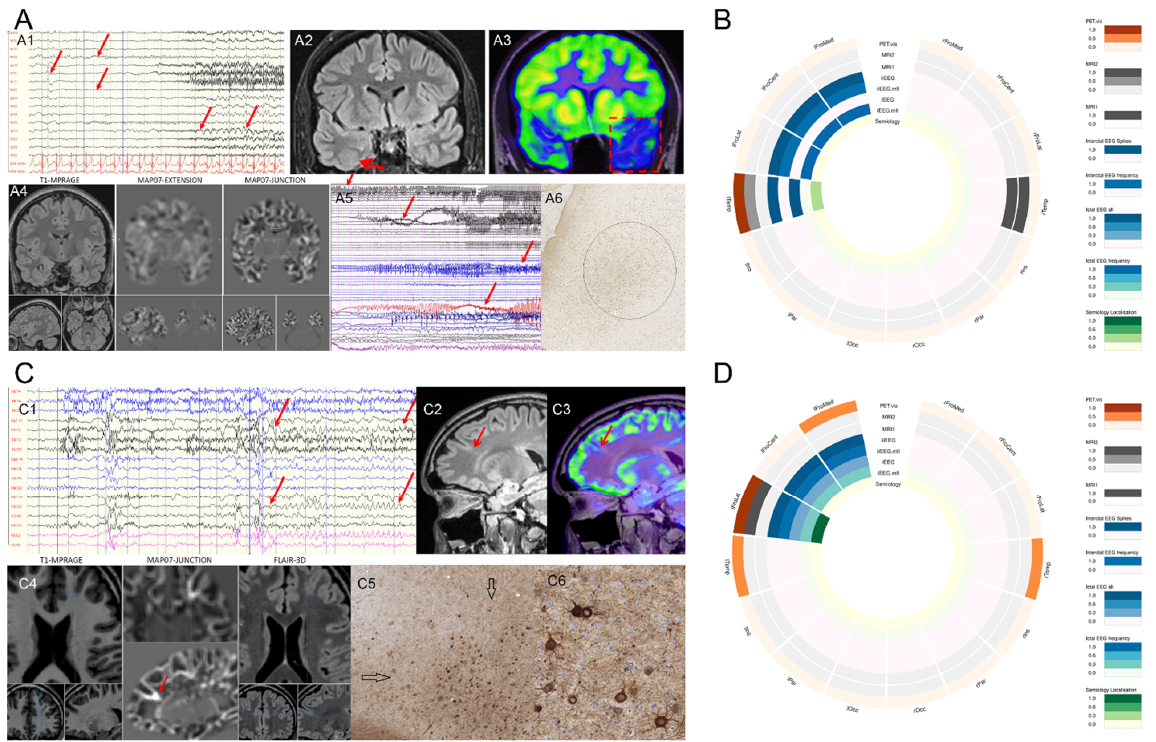
Figure 1. Examples of the results of presurgical evaluation tests proved by pathologic findings. ( A ) A drug-resistant epileptic patient with atypical temporal lobe seizures. ( A1 ) Video-EEG monitoring. During her stereotype seizures, left frontotemporal seizure activity was seen (marked with arrows). ( A2 ) A cranial MRI showed an FCD2 in the right collateral sulcus (arrow), while ( A3 ) [ 18 F]-FDG PET/MRI presented a PET hypometabolism in the left temporal lobe (square). ( A4 ) The junction map from the MAP07 analysis did not reveal any lesion in the temporal regions. ( A5 ) An iEEG monitor was performed because of discordant results. Habitual seizures were registered, and the intervention was conclusive, resulting in a left temporal pole resection (resected region marked with dashed red box) with an Engel I/a outcome (24 months of seizure-free period). ( A6 ) Histopathology (NeuN stain) proved an FCD1 in the left temporal pole with irregularly arranged neurons. ( B ) The circular plot refers to the electro-clinical data and imaging modalities of the patient in panel A. ( C ) A drug-resistant epileptic patient with hypermotor seizures. ( C1 ) Video-EEG monitoring showed short, stereotype seizures, with left frontal seizure activity (between the arrows). Before the hybrid [ 18 F]-FDG PET/MRI study, all MRI investigations were negative. ( C2 ) The cranial MRI showed an FCD 2 connected to the left superior frontal sulcus, which was in concordance with ( C3 ) [ 18 F]-FDG PET/MRI presented a PET hypometabolic pattern. ( C4 ) The junction map of MAP07 analysis also detected the lesion (red arrow). Epilepsy surgery with intraoperative electrophysiology was performed targeting this lesion, with an Engel I/a outcome (24 months of follow-up). ( C5 ) Histopathology identified an FCD 2a with dysmorphic neurons (arrows; the region is shown in higher magnification in ( C6 ) characterized by a lack of anatomical orientation and accumulation of neurofilaments (SMI32, neurofilament immunohistochemistry). ( D ) The circular plot refers to the electro-clinical data and imaging modalities of the patient in panel C. The patterns of presurgical evaluation tests and electroclinical data demonstrated a wide variety of